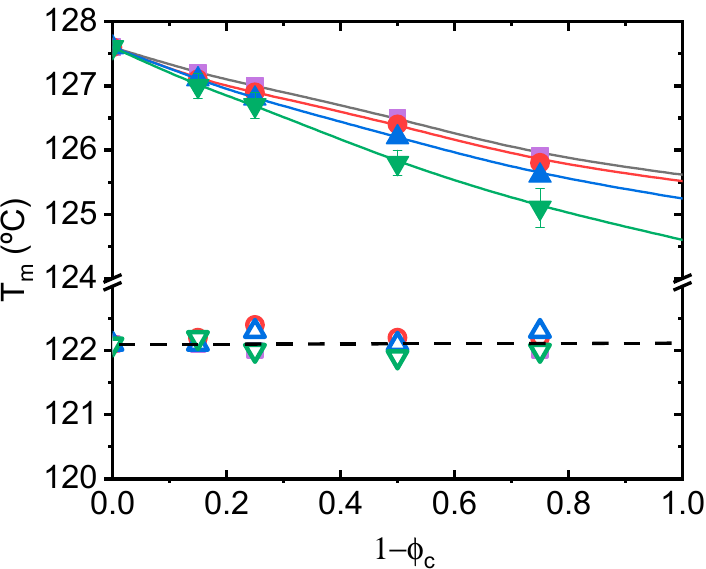
Figure 4. Melting peak temperature compositional dependence for PE0.0 (solid symbols) and PE_ZN (hollow symbols) mixed with EEA (circles), EVA (up triangles), EMAANa (down triangles) and PCL (squares).